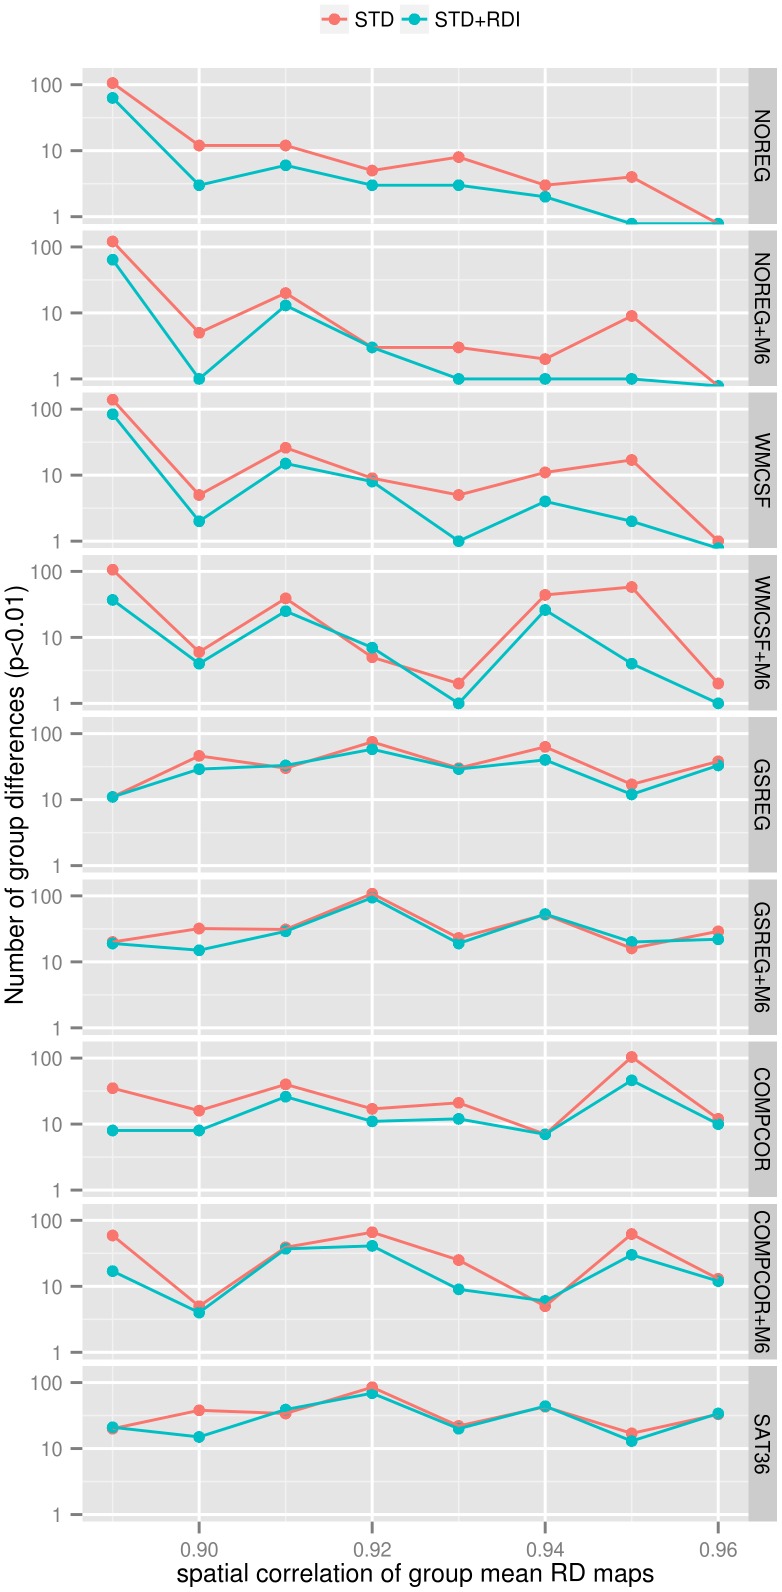
The effect of RDI on motion-related group differences.The number of significantly (p<0.01) differing connections is plotted against the spatial correlation coefficient of group-mean voxel-wise displacement maps for RD-based group-pairs for each nuisance signal regression method. The number of significant group differences is plotted on logarithmic axis. Improvement in the reduction of motion-related group differences was most pronounced for the NOREG, WMCSF and COMPCOR methods. Nuisance regression methods incorporating GSREG seem not to be sensible for differences in group-mean voxel-wise displacement patterns however, they show relatively high number of group differences by all group comparisons.